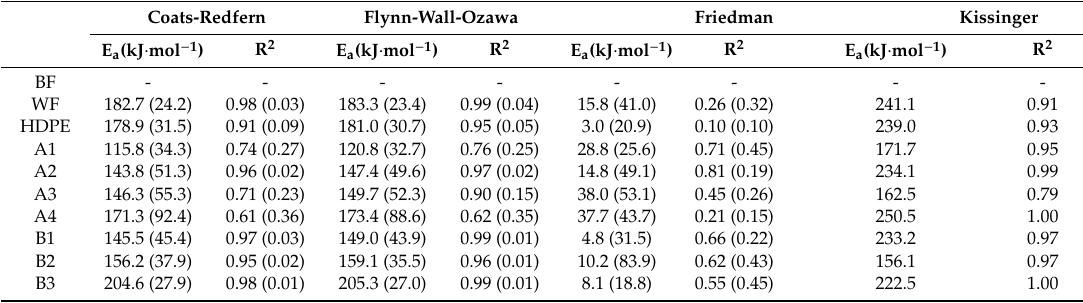
Table 6. Coats-Redfern (C-R) and Flynn-Wall-Ozawa (F-W-O) assessments of the apparent activation energy of the materials.